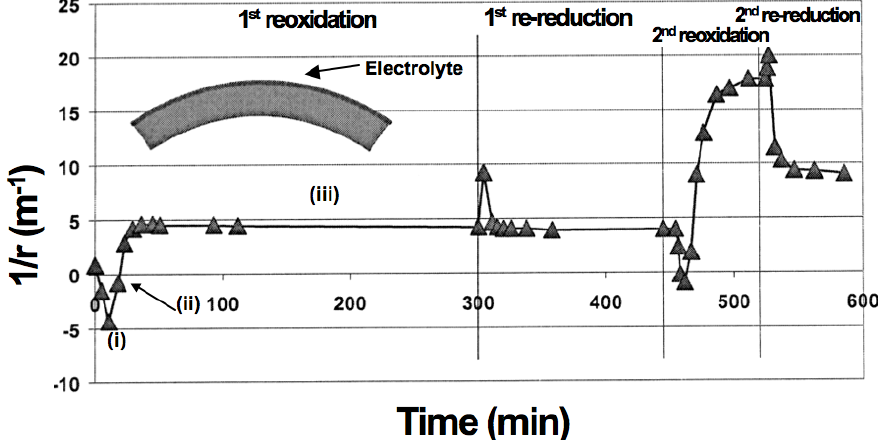
Figure 7. Curvature change during reoxidation and re-reduction cycles (0.27 mm half-cell, 800 °C) [97]. During re-oxidation, the half-cell shows ( i ) an initial curvature towards the electrolyte (on the concave side); then ( ii ) it reverts to “zero”-curvature and finally ( iii ) it stabilizes with a curvature towards the anode (on the concave